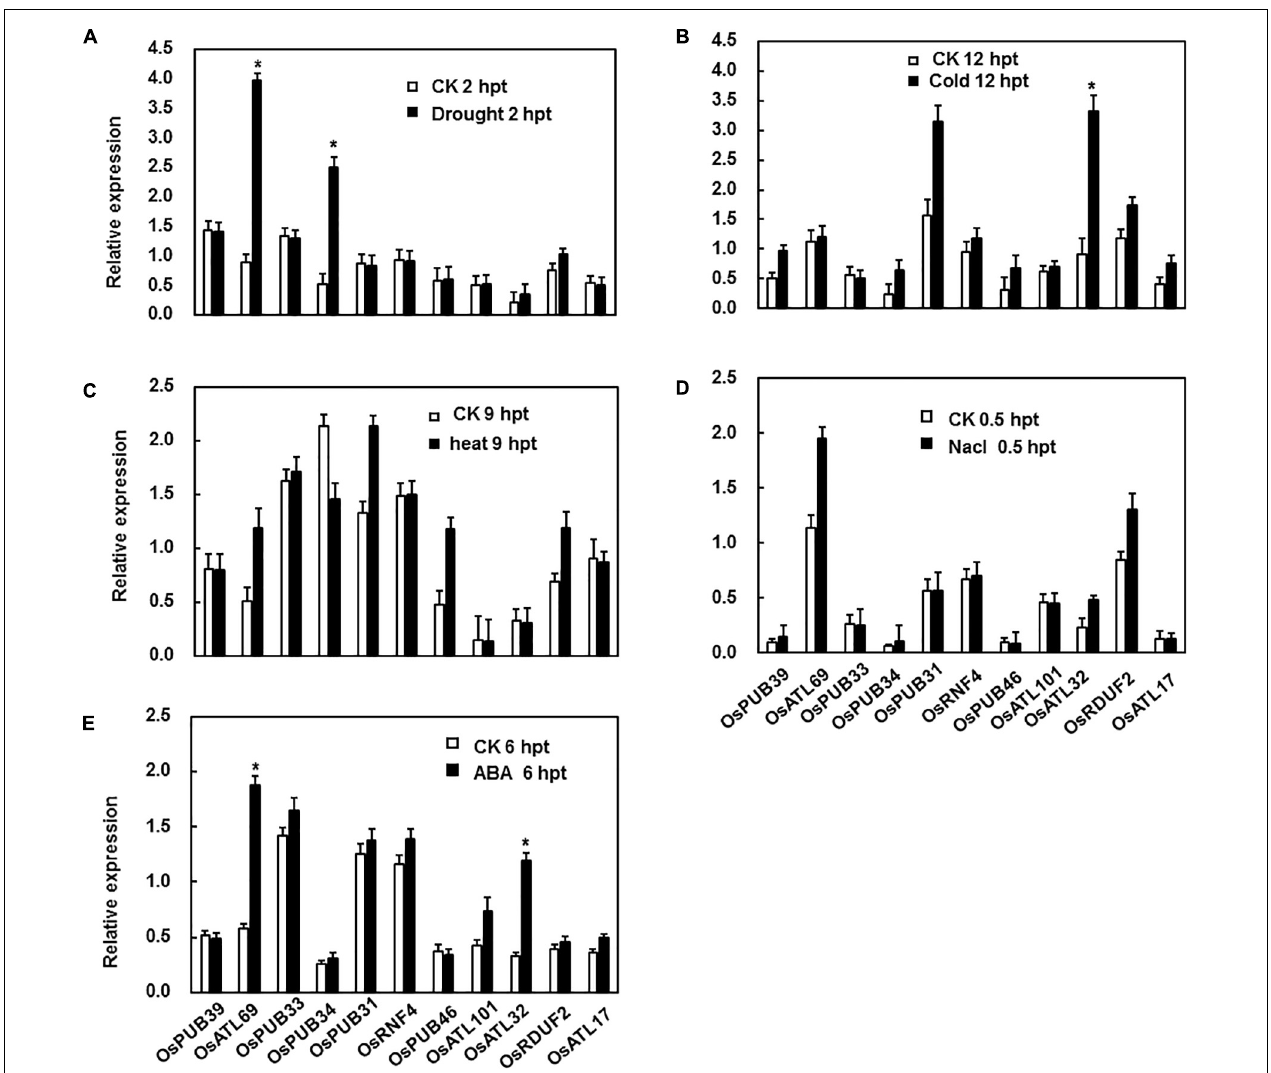
FIGURE 2 | Expression patterns of E3 ubiquitin ligase genes in response to abiotic stress and ABA treatment. (A) For drought stress, the hydroponic 3-week-old plants were placed on the frame floor in the greenhouse after the water on the surface of the root was dried by filter paper. For cold (B) and heat stress (C) , 3-week-old plants were placed in a climatic cabinet at 4 ◦ C and 42 ◦ C. (D) For salt stress, hydroponic 3-week-old plants were placed in a 200 mM NaCl solution. (E) Expression patterns of E3 ubiquitin ligase genes in response to ABA. Leaves of 4-week-old Yuanfengzao seedlings were sprayed with 100 µ M ABA solution. Ethanol (0.1%) was used as the control. The samples were harvested at specific time points for the analysis of gene expression. Expression levels were presented as multiples of the OsActin expression level, which was used as a standard. Data presented are the means ± SD from three independent experiments, and * above the columns indicate significant differences between the treated and control plants at p < 0.05